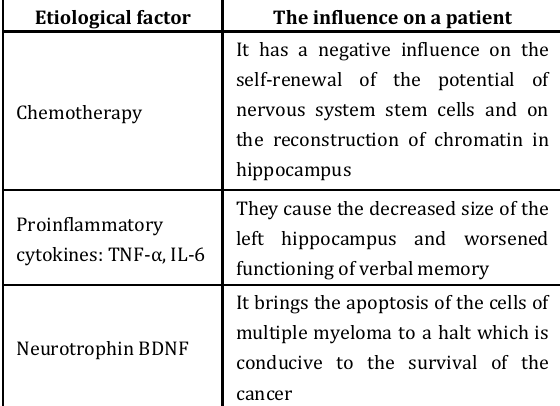
Table 1. The relationship between the causes of chemo- brain and their influence on cancer patient’s organism and